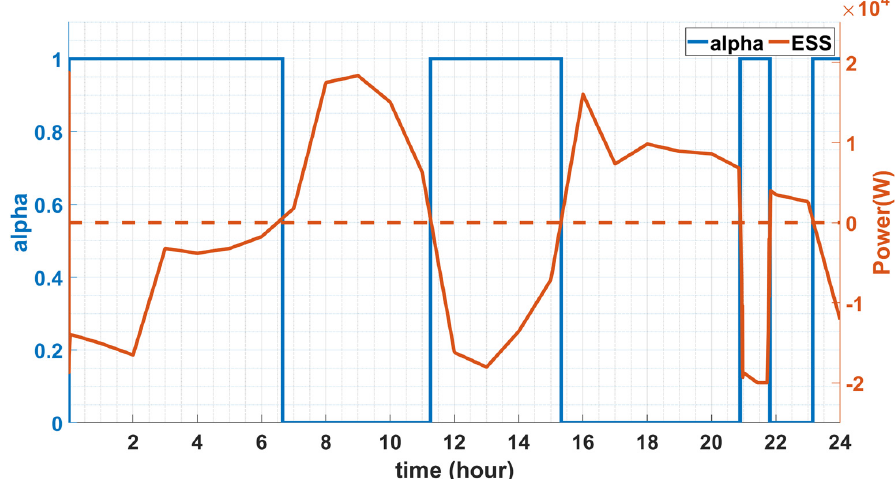
Figure 13. Bus voltage of the stand-alone MG.